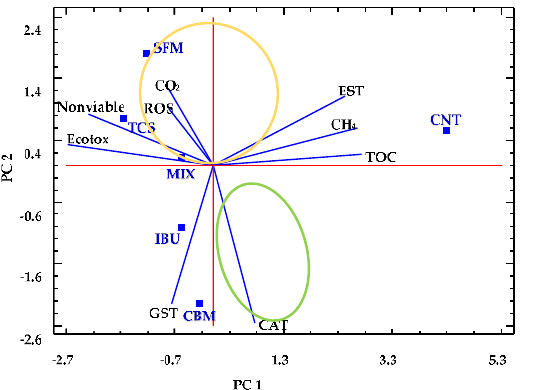
Figure 5. Principal component analysis (PCA) for anaerobic digesters. Squares represent the biore- actors containing PPCPs (SFM, TCS, IBU, CBM, MIX) and the reactor free of pollutants (CNT). Lines indicate the parameters measured, including chemical (TOC, CH 4 , CO 2 ) and biochemical (EST, ROS, GST, CAT, nonviable cell fraction and Ecotox).